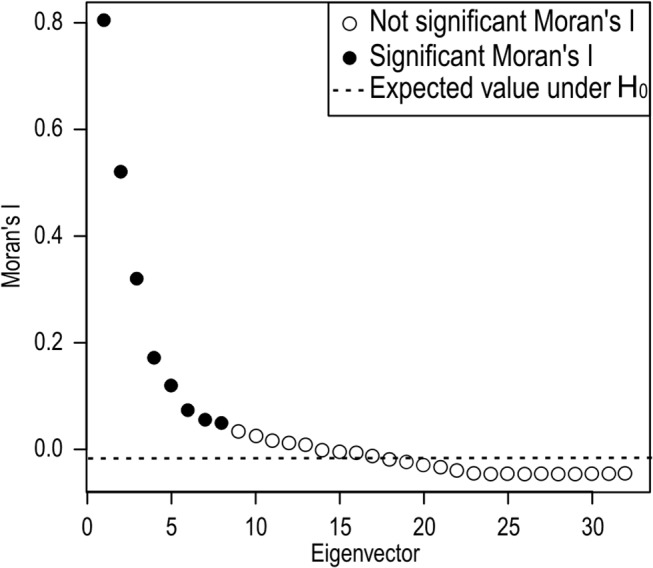
Moran’s I index of the cluster structure of Parmelina tiliacea.